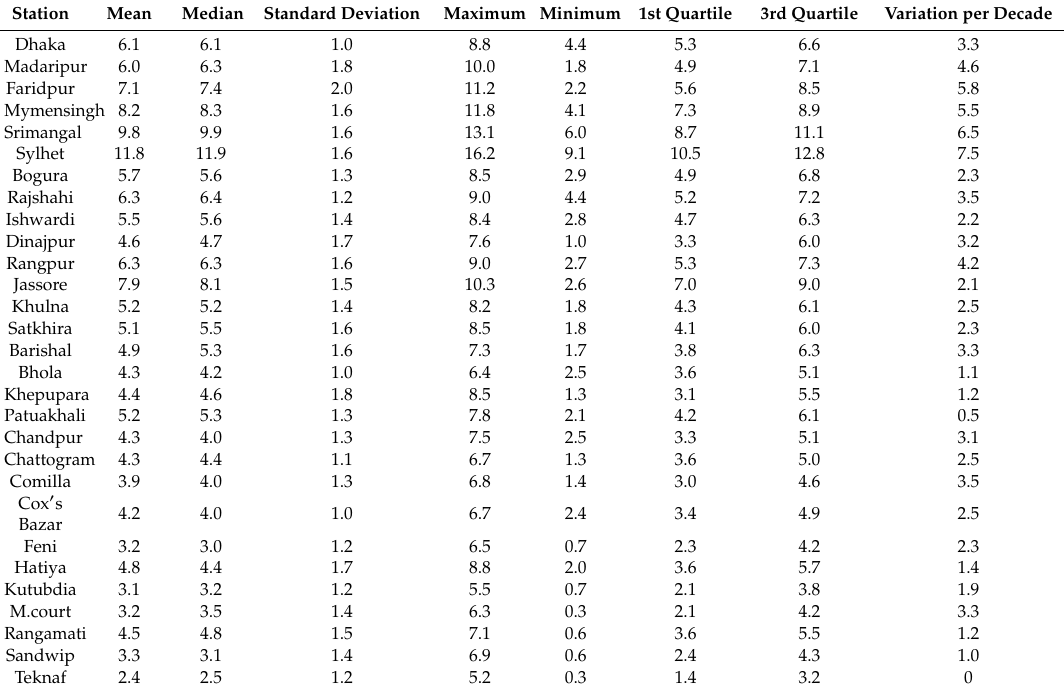
Table A1. Descriptive statistics of the annual average TS days over Bangladesh during 1975–2016.